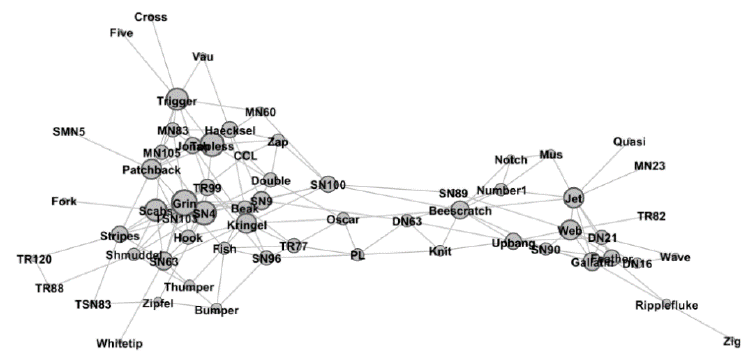
Figure 1. Dolphin social network.